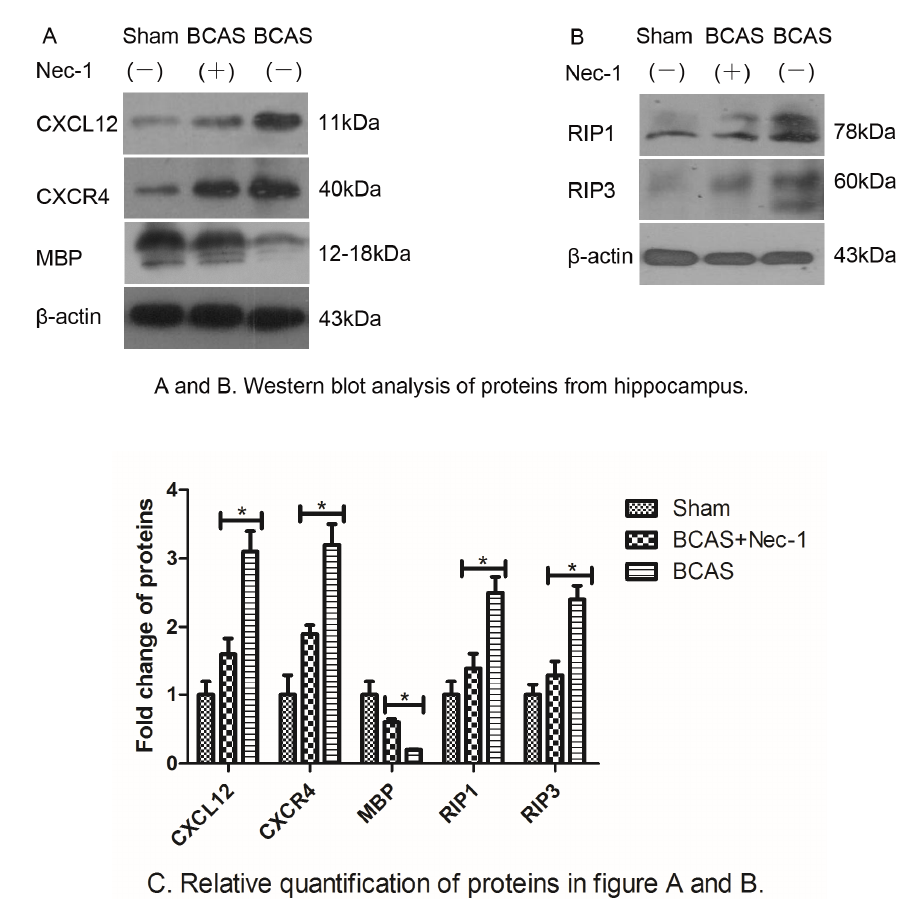
Figure 6. Western blot analysis of proteins from hippocampus. ( A ) The level of CXCL12, CXCR4, MBP and β -actin proteins. The mice in the BCAS group had significantly higher levels of CXCL12 and CXCR4 proteins, but lower level of MBP protein than in the BCAS with Nec-1 group (* p < 0.05); ( B ) The level of RIP1, RIP3 and β -actin proteins. The mice in the BCAS group had significantly higher levels of RIP1 and RIP3 proteins than in the BCAS with Nec-1 group (* p < 0.05). 2.5. Inflammatory Cytokine Protein and mRNA Levels were Reduced by Nec-1 RT-PCR and ELISA were used to evaluate the changes of inflammatory cytokines in protein and mRNA levels. In the Figure 7, there was a down-regulation of TNF- α , INF- γ , IL-1 β and IL-33 protein expression at the 15th day after Nec-1 treatment (A–D). Nec-1 reduced TNF- α , INF- γ , IL-1 β and IL-33 mRNA expression at the 15th day after BCAS (E).